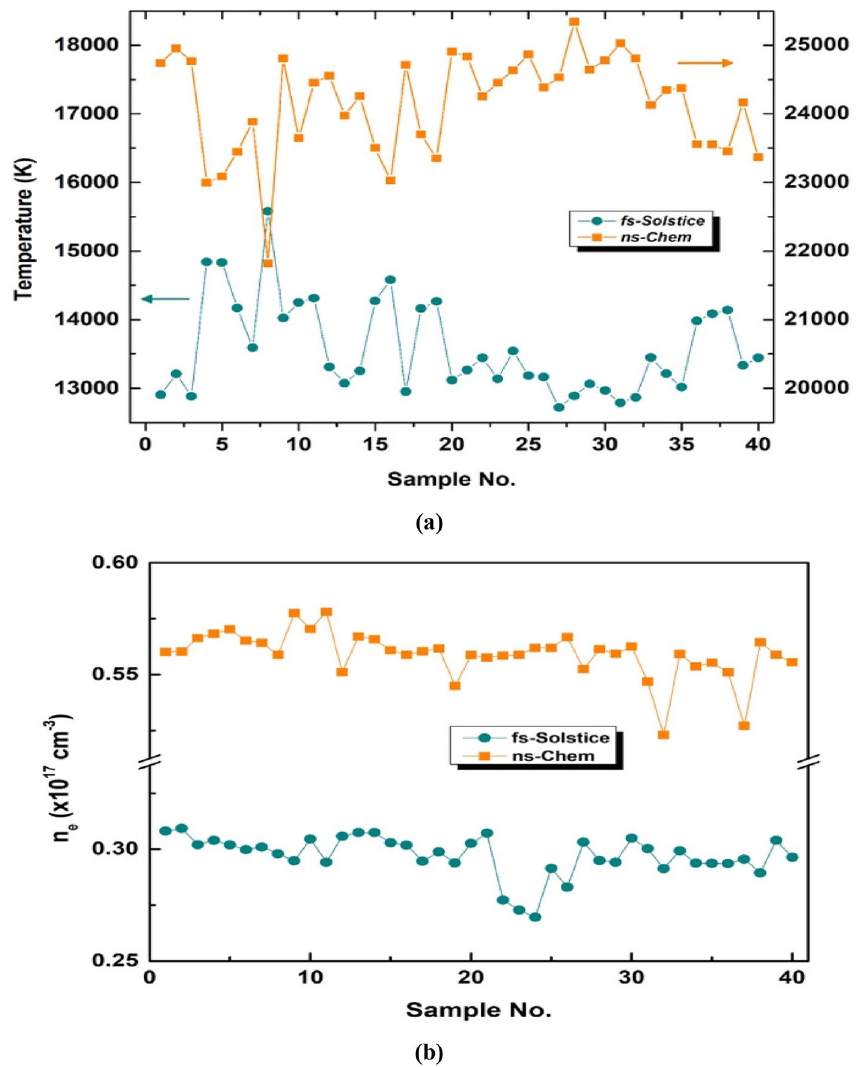
Figure 11. Plasma temperatures in ( a ) and electron densities in ( b ) for 40 coal samples ablated with fs-Solstice and ns-Chem plasmas. The average temperature value for fs system is 13,583 ± 679 K while for ns system is 24,151 ± 732 K. The average electron number densities are 2.97 ± 0.09 × 10 16 cm −3 for fs plasma and 5.59 ± 0.10 × 10 16 cm −3 for ns